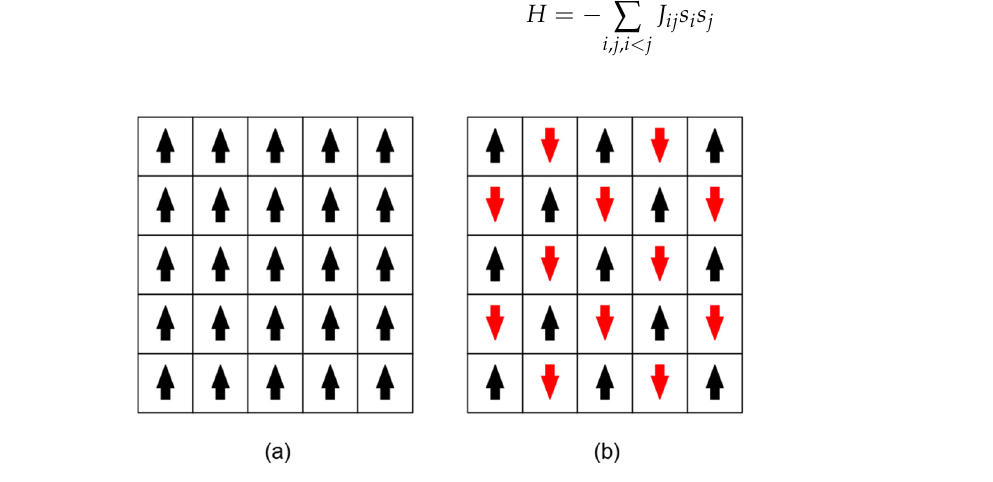
Figure 4. Schematic illustration of spin configuration in a ( a ) ferromagnetic system; ( b ) antiferromagnetic system.